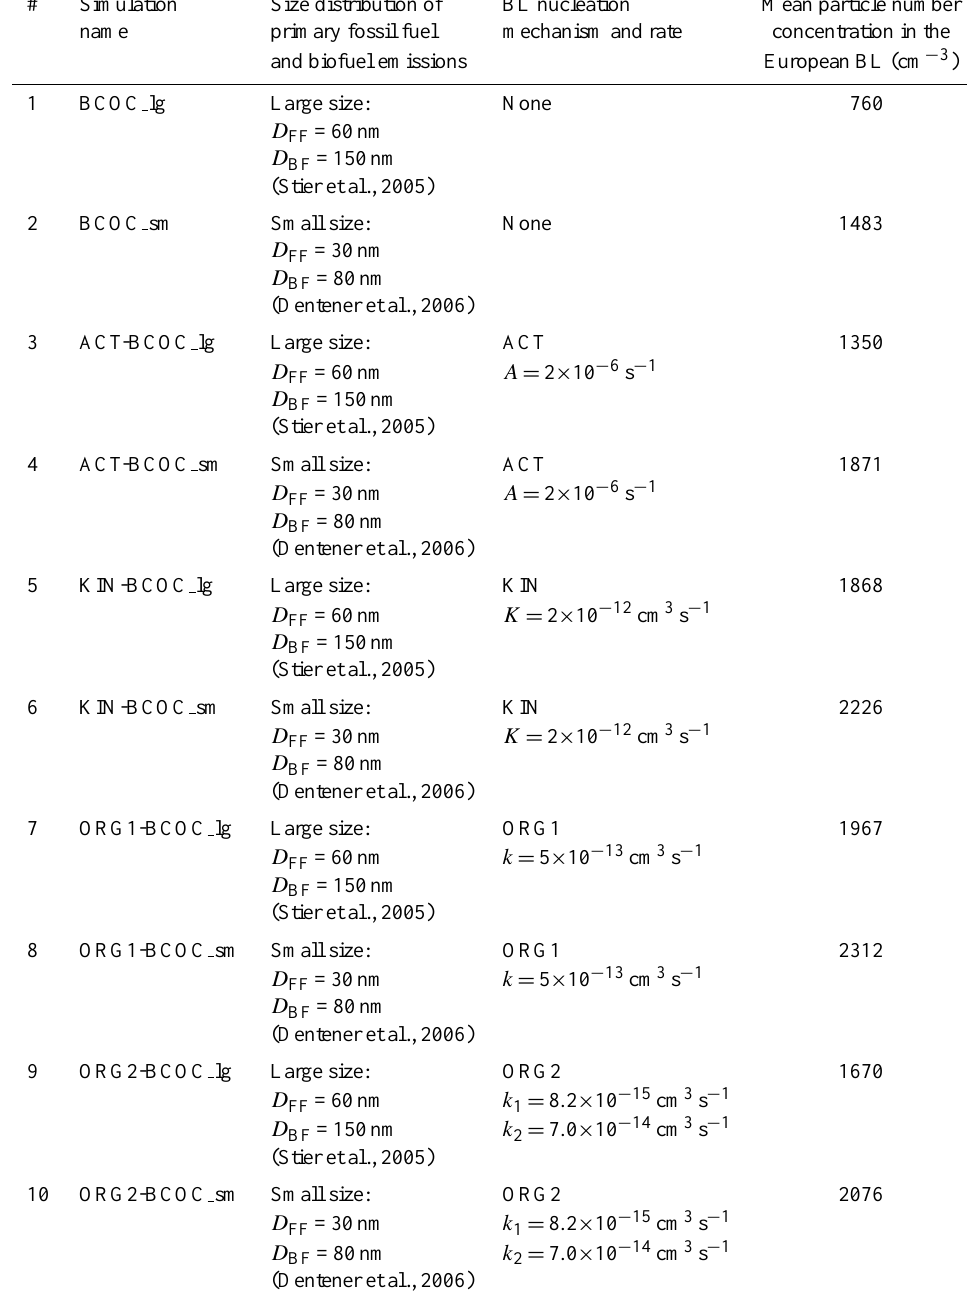
Table 2. Summary of the GLOMAP model simulations used in this study. All model simulations include primary aerosol emissions and binary homogeneous nucleation of H 2 SO 4 –H 2 O (Kulmala et al., 1998) to simulate nucleation in the FT (see Sect. 3 for details). Modelled campaign (May 2008) mean particle number concentrations ( D p > 3nm) in the European BL ( ≤ 2000m a.s.l.) are given for each simulation. The European domain is considered as the area between the longitudes ∼ 65 . 6 ◦ N and ∼ 32 . 1 ◦ N, and latitudes ∼ 22 . 5 ◦ W and ∼ 36 . 6 ◦